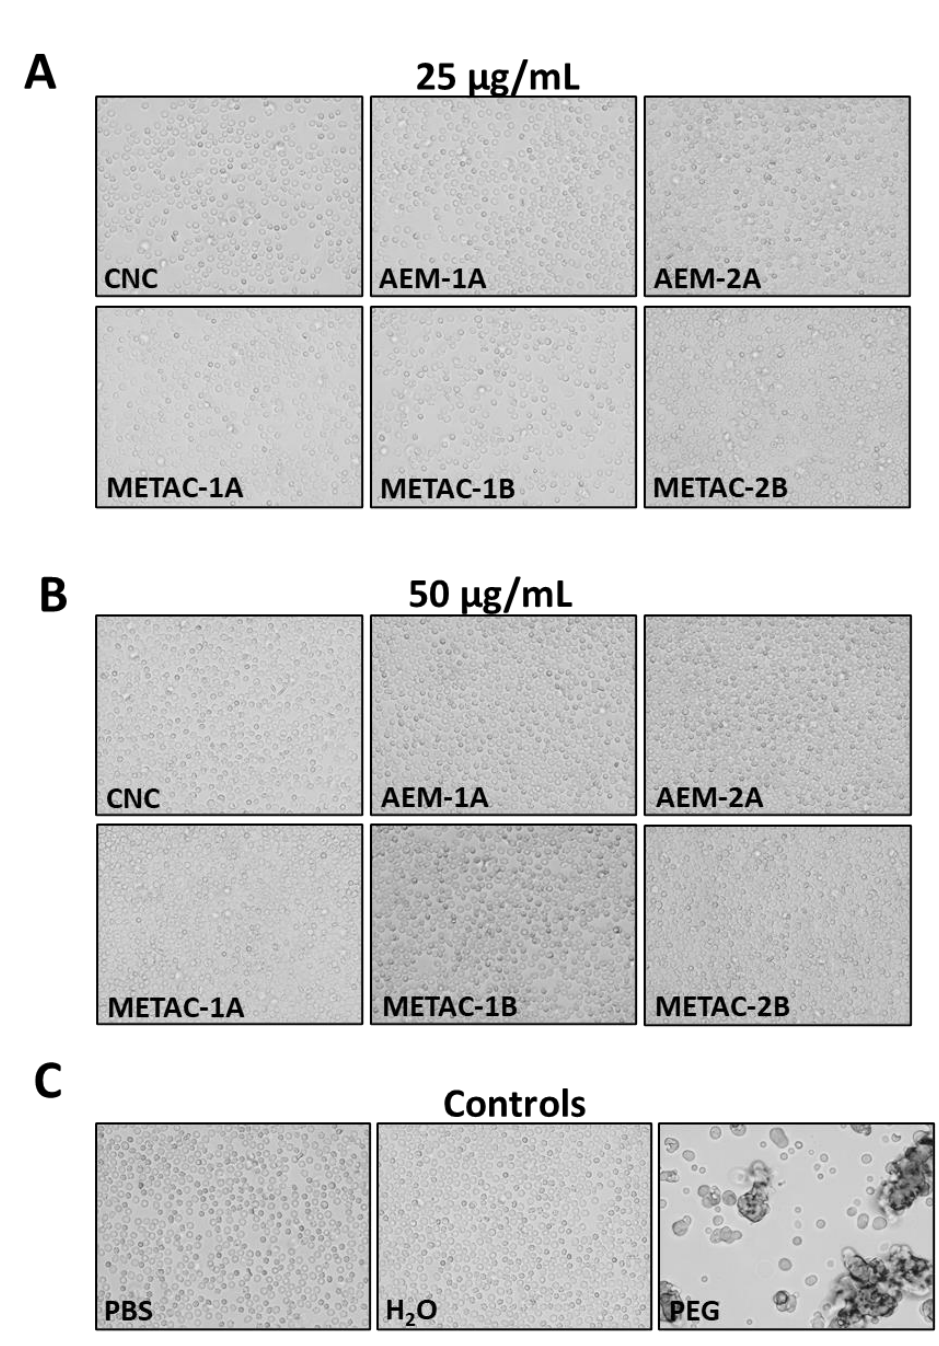
Figure 3. Effect of unmodified and modified CNCs on RBC morphology and aggregation. Diluted human blood was treated for 24 h with ( A ) 25 µg/mL or ( B ) 50 µg/mL of unmodified and modified CNCs, or with controls, ( C ) PBS, ultrapure H 2 O, and PEG 1 mg/mL. The pictures were captured using a bright-field inverted microscope (400×).